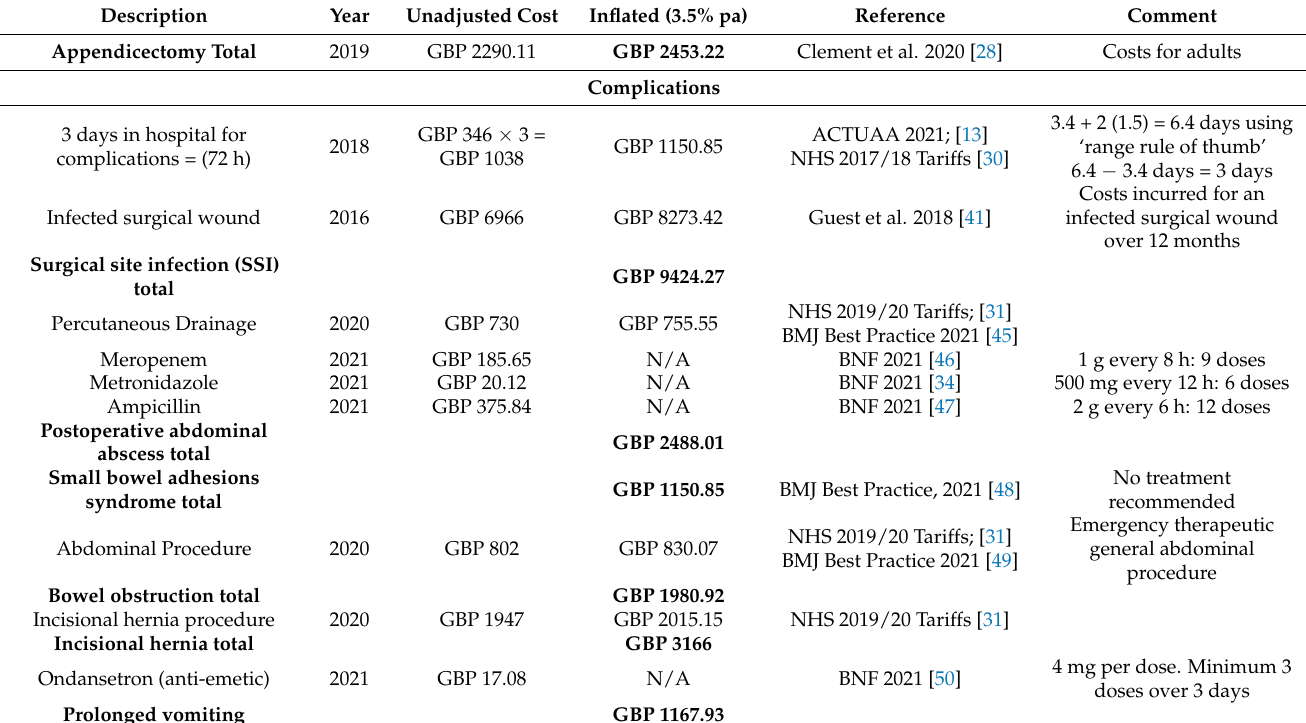
Table A4. Costs of appendicectomy (the cost for extra days in hospital was added on to each complication to produce a total cost).